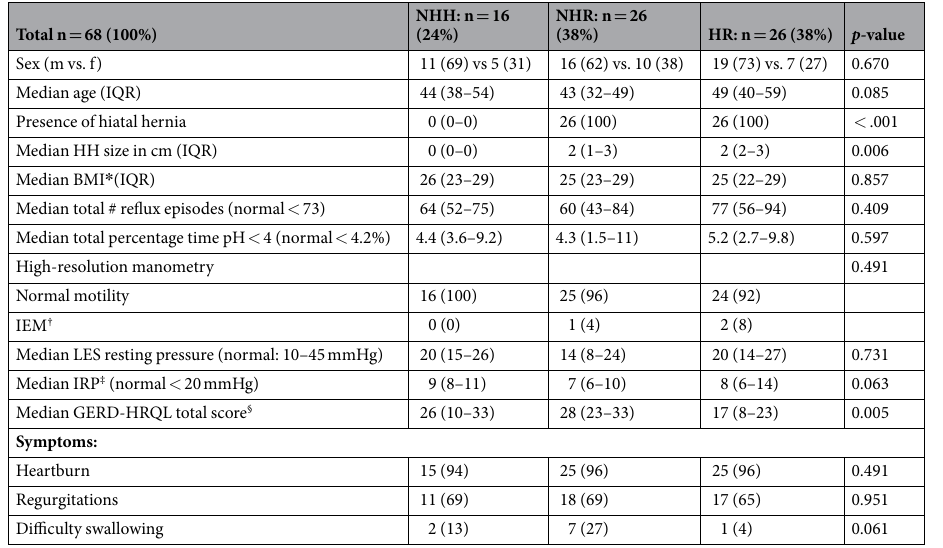
Table 1. Demographic data and results of preoperative diagnostics. Error analysis: standard deviation. Numbers provided in tables are medians (IQR). * BMI = Body Mass Index; † IEM = ineffective esophageal motility; ‡ IRP = integrated relaxation pressure of LES; § GER-HRQL total score ranges from